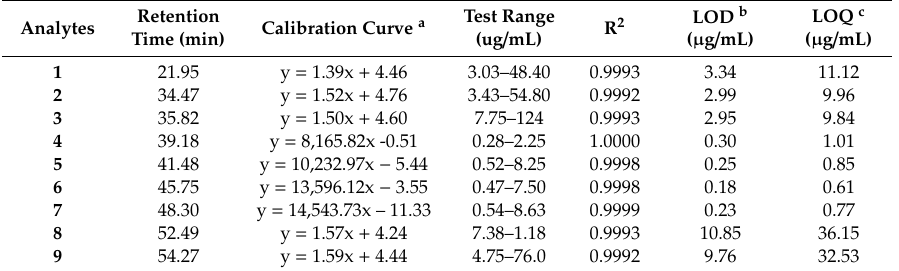
Table 2. Linear regression data, LOD and LOQ of the nine triterpenoids in P. guajava.